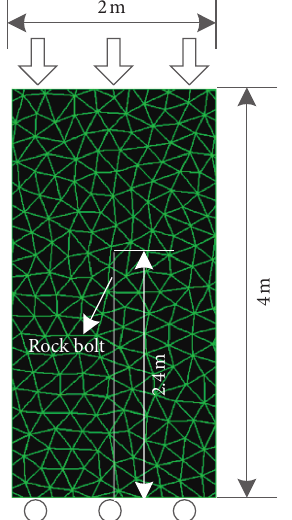
Figure 2: Model overview and dimensions.